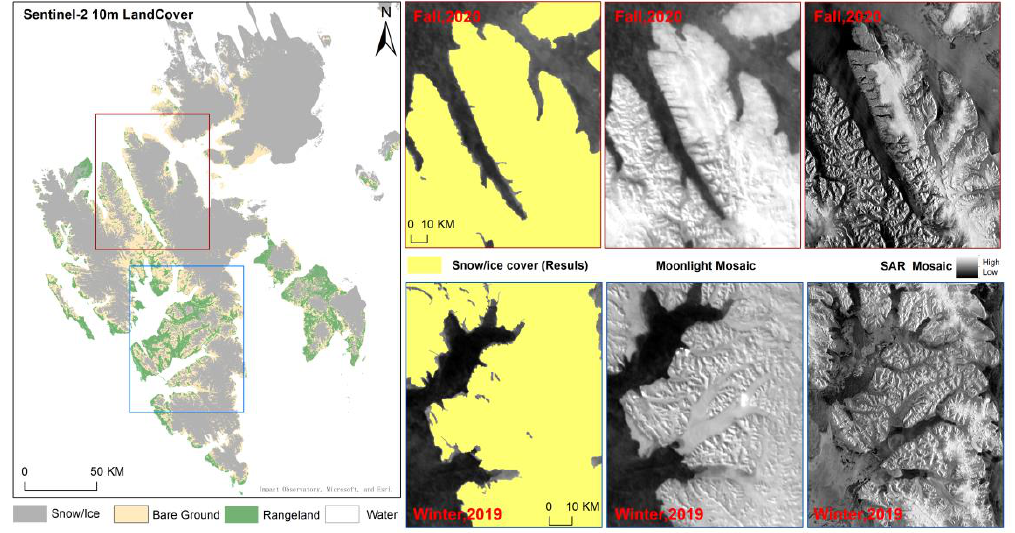
Figure 16. Comparison of snow/ice cover classification using moonlight and Sentinel-1 SAR mosaic images in 2019 and 2020.